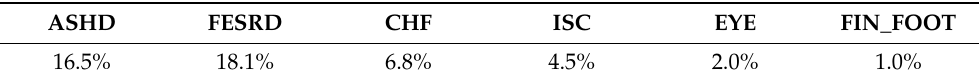
Table 3. Incidence proportion of study complications in the patients with type 2 diabetes mellitus within 15 years. ASHD FESRD CHF ISC EYE FIN_FOOT 16.5% 18.1% 6.8% 4.5% 2.0% 1.0%